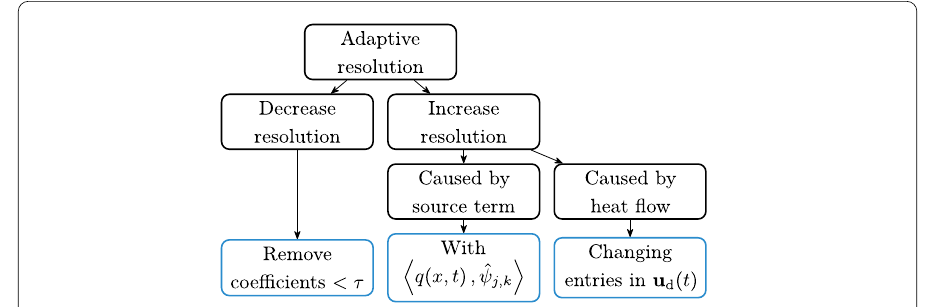
Figure 4 Flow chart for adapting the